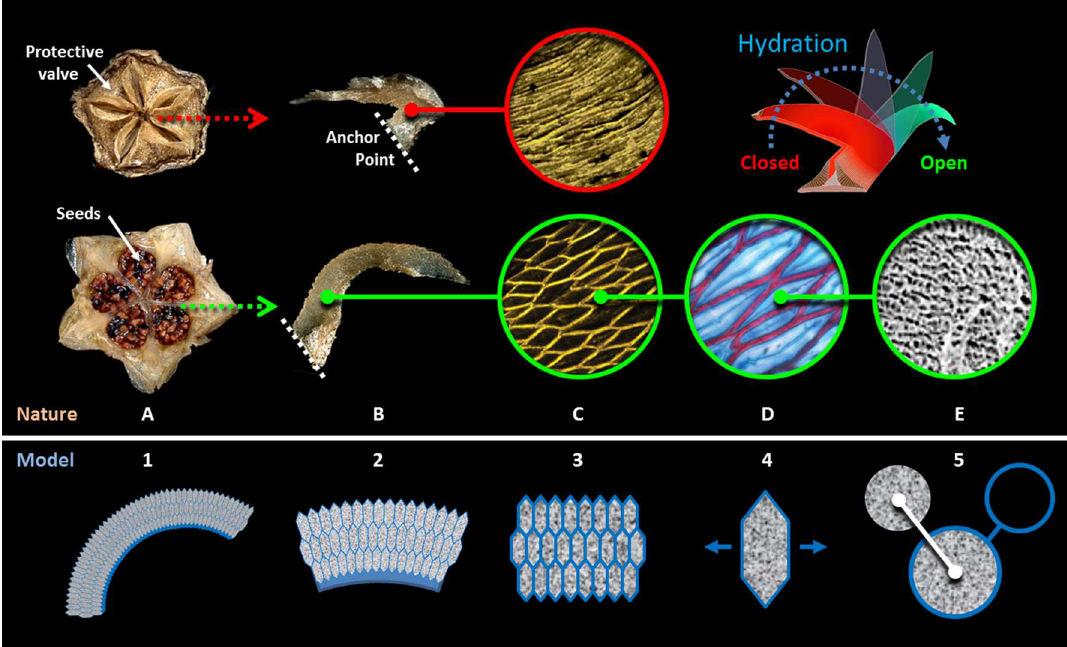
Fig 1. Ice plant hydro-actuation mechanism. Top: (A) The seed capsules of the ice plant, Delosperma nakurense are shown in dry (closed) and wet (open) state. The five seed containingcompartments are closed and covered by a protective valve (each measuringca. 3mm in length) in the dry state and open upon wetting. (B) Two hygroscopic keels halves responsible for unfolding/folding of the seed capsule; the keels are bent inward in the dry state and bend outward upon hydration.(C) Each keel consists of a network of ellipsoid/hexagonal shape cells (confocal microscopy images of the transverse cell cross-section -field diameter: ca. 0.4 mm). (D) A highly swellablecellulosic inner layer filling up the lumen of the cells is responsible for the unidirectional openingof the cells and the reversibleanisotropicexpansion/contraction of the cell-network upon wetting/drying cycles (FCA stained cells cross section with lignifiedcell wall stained in red and the cellulosicinner layer in blue- field diameter: ca. 100 μ m). (E) Cryo-SEM micrograph of the cellulosicinner layer (field diameter: ca. 20 μ m). (redrawnafter [8, 20]). Bottom: Abstraction of the actuation principles from lower to higher lengthscale; (5) volume changeof a highly swellablematerial inside a circular confinement induces an isotropic volume change of the cell; (4) Tailoring the geometry of such cell enables an anisotropicdeformation upon swelling/shrinkage cycles; (3) Through periodicarrangement of the cells, the cooperative anisotropicdeformation of individualcells results in a unidirectional expansion/contraction of the cellularstructure at a larger length scale,(2,1) which can be translated into bendingof the whole honeycomb structure when the deformation is restricted at one side (re-sketched after